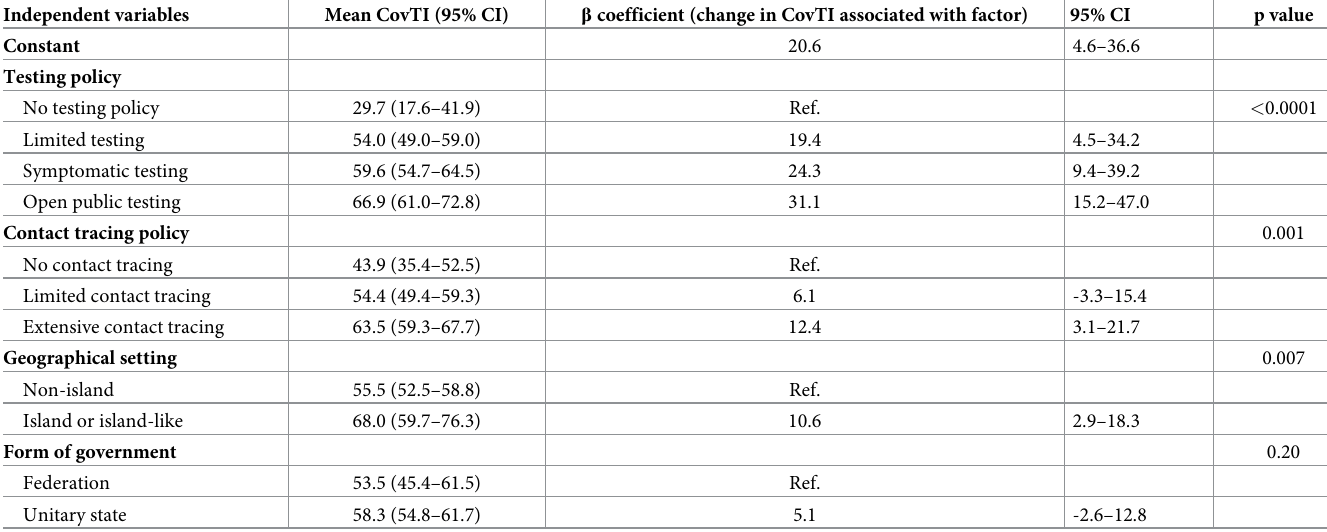
Table 5. Multiple linear regression analysis F(7, 139) = 7.07 (p < 0.0001), adjusted R 2 = 0.23 of factors associated with COVID-19 Testing Index from final model (n = 147) (data from 00:00 GMT June 3,